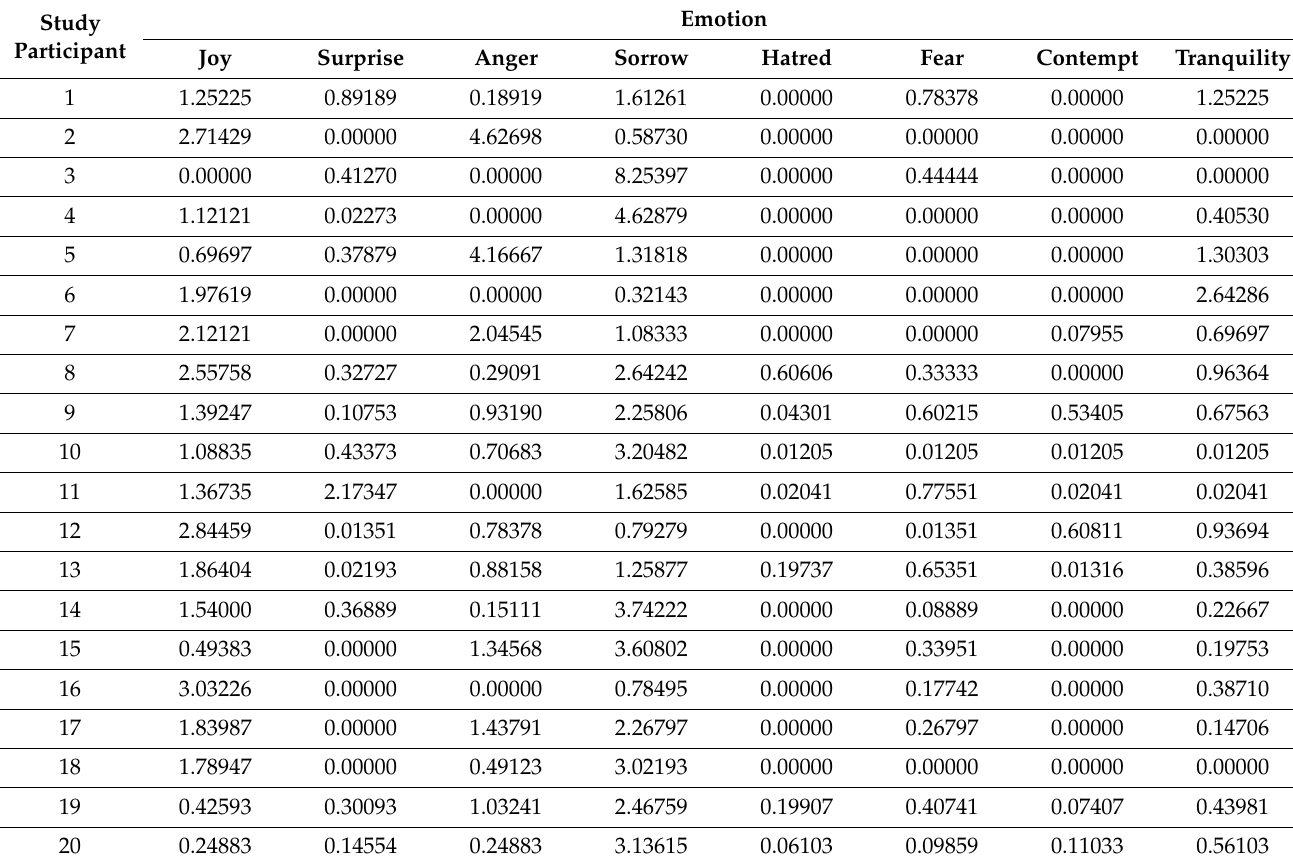
Table 2. Emotion vectors of 20 survey